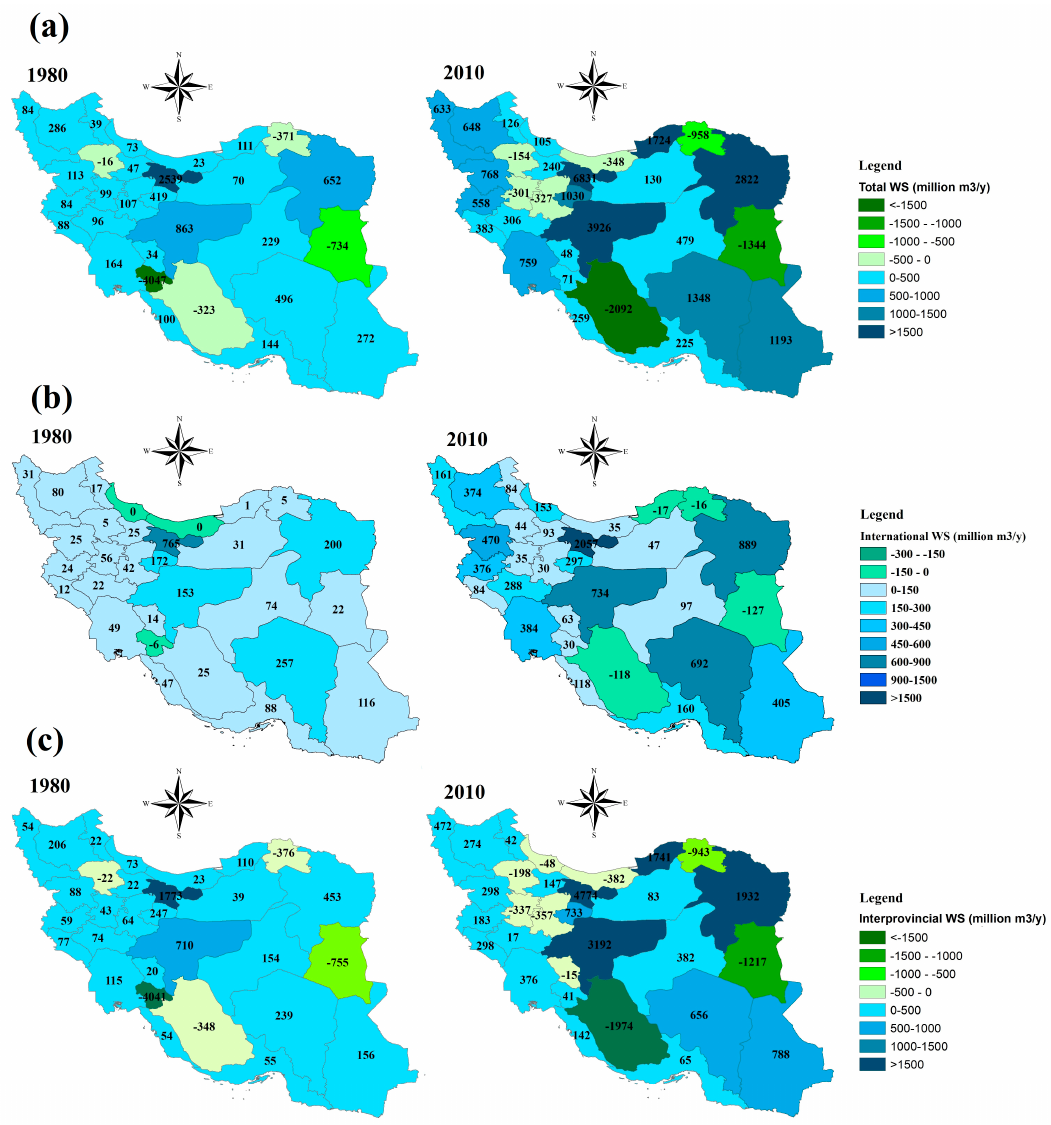
Figure 14. Blue water saving (WS) as a result of total ( a ), international ( b ), and interprovincial ( c ) crop trade, per province, in 1980 ( left ) and 2010 ( right ).